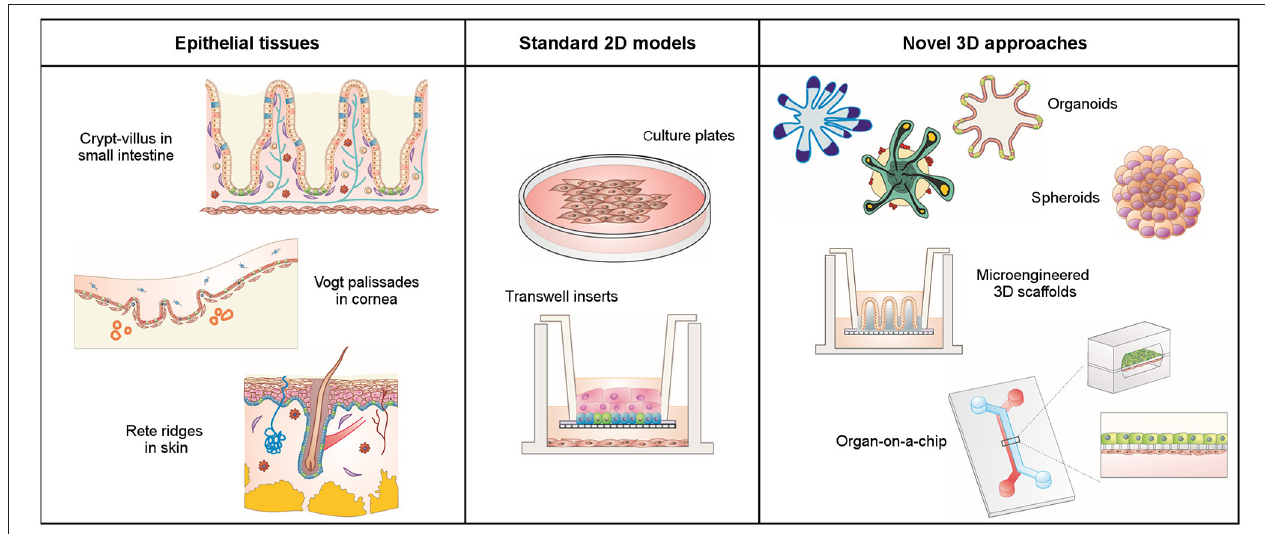
FIGURE 1 | Schematic representation of epithelial tissues with their native 3D architecture, conventional 2D cell cultures, and novel 3D cell culture